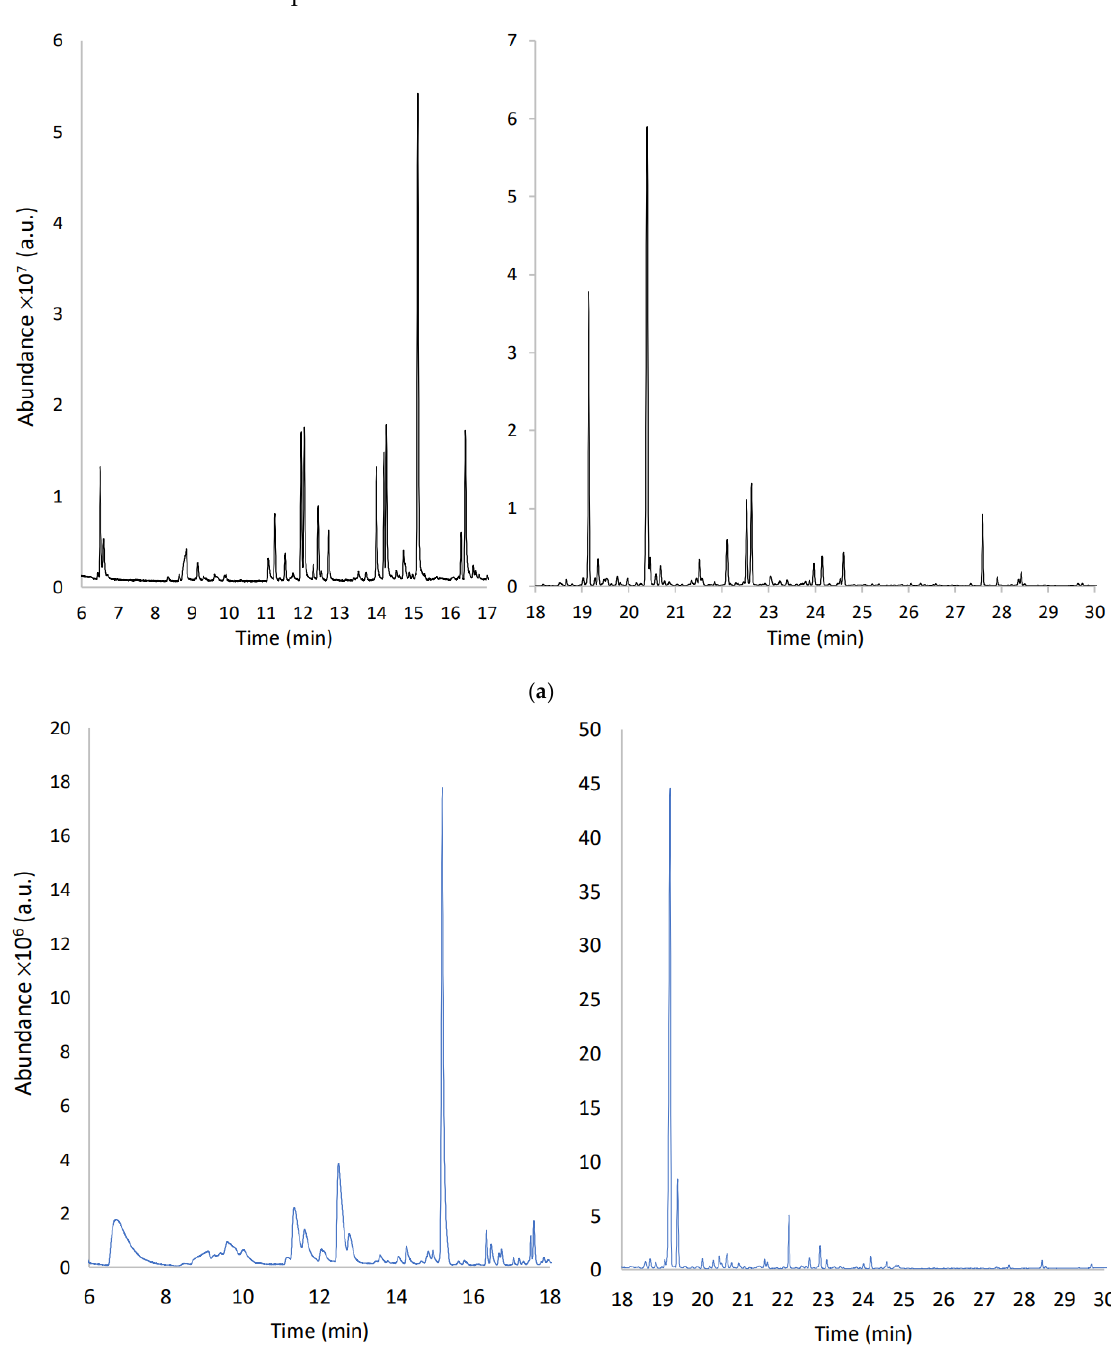
( c ) Figure 3. ( a ) TIC (Total Ion Current) chromatogram of the VOCs from G_WDF fibrous sample obtained by HS-SPME-GC-MS (a.u. = arbitrary units). ( b ) TIC chromatogram of the VOCs from AM_WDF fibrous sample obtained by HS-SPME-GC-MS (a.u. = arbitrary units). ( c ) TIC chromatogram of the VOCs from CS_WDF fibrous sample obtained by HS-SPME-GC-MS (a.u. = arbitrary units).